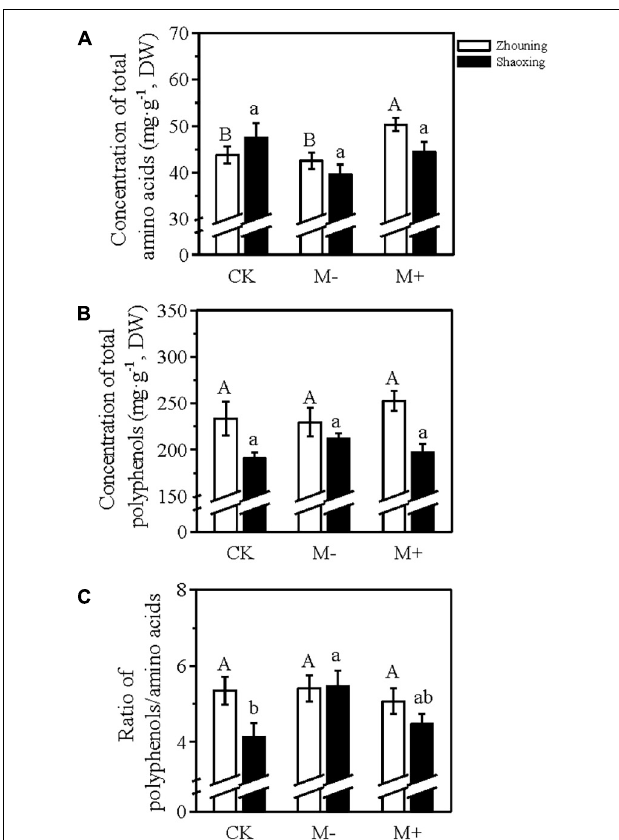
FIGURE 7 | The changes of the total amino acids (A) , polyphenols (B) , and the polyphenol/amino acid ratio (C) of tea plants grown under a 25% reduction of local soil fertilization level with (M+) or without ( − ) foliar N application. DW, dry weight. CK, tea plants cultivated with the local soil fertilization level in Zhouning or Shaoxing but without foliar N application. Values were shown as means ± SEs ( n = 6 for all the samples from Shaoxing and Zhouning). The significance of different treatments from the same district was evaluated using one-way ANOVA followed by a Duncan test at a significance level of P 0 . 05 in the SPSS 22.0 software. Statistically significant differences ( P < 0.05) among the treatments in Zhouning and Shaoxing were shown with a capital letter and a lower case letter displayed above the bar plot,